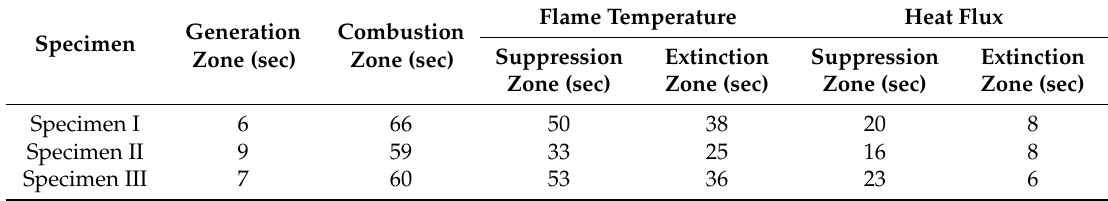
Table 3. Comparison of the fire-extinguishing performances.